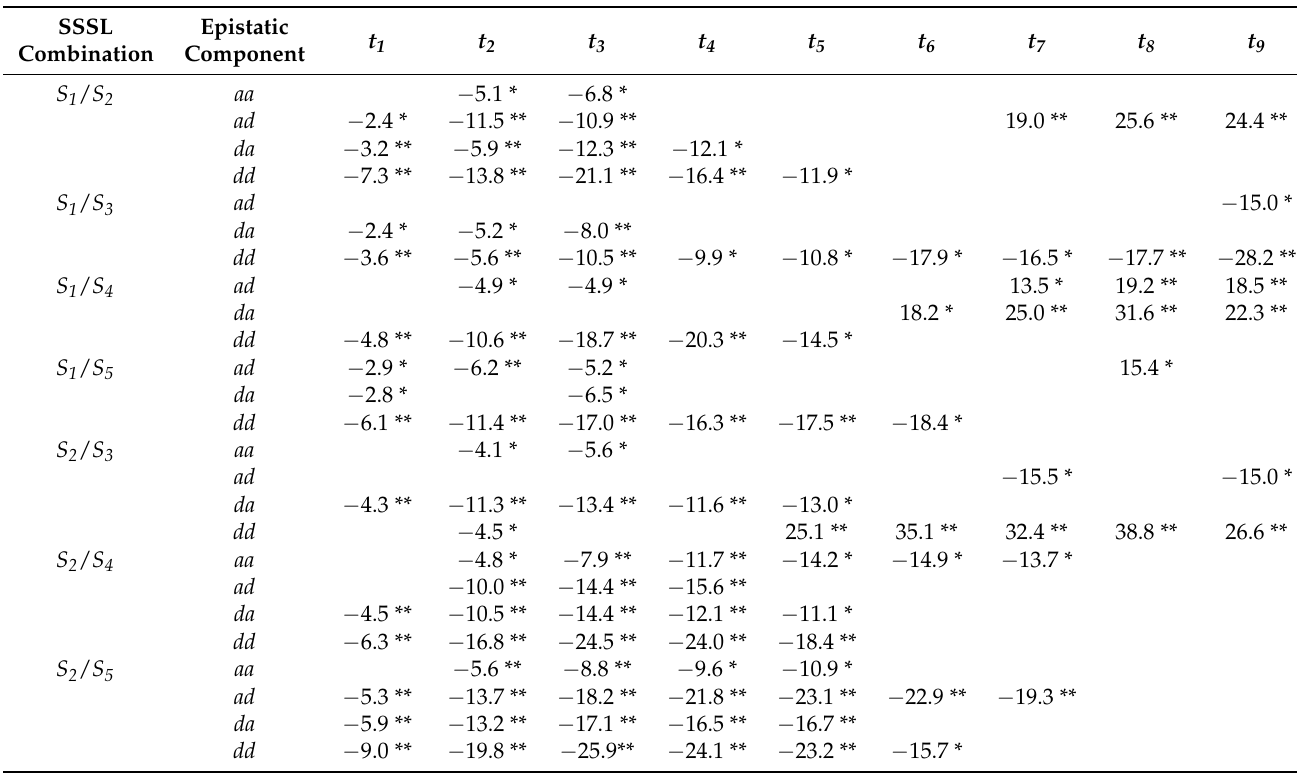
Table 3. Epistatic effects of the estimated QTLs on the leaf number in various developmental stages. SSSL is an abbreviation of single-segment substitution line. S i / S j represents the combination of SSSL i and SSSL j . aa, ad, da , and dd represent additive-additive, additive-dominant, dominant-additive, and dominant-dominant epistases, respectively. t i indicates the i th stage of the measurement. “ − ” indicates descending leaf numbers due to alleles from the donors. * and ** show significance at the levels of the 0.05 and 0.01 probabilities,